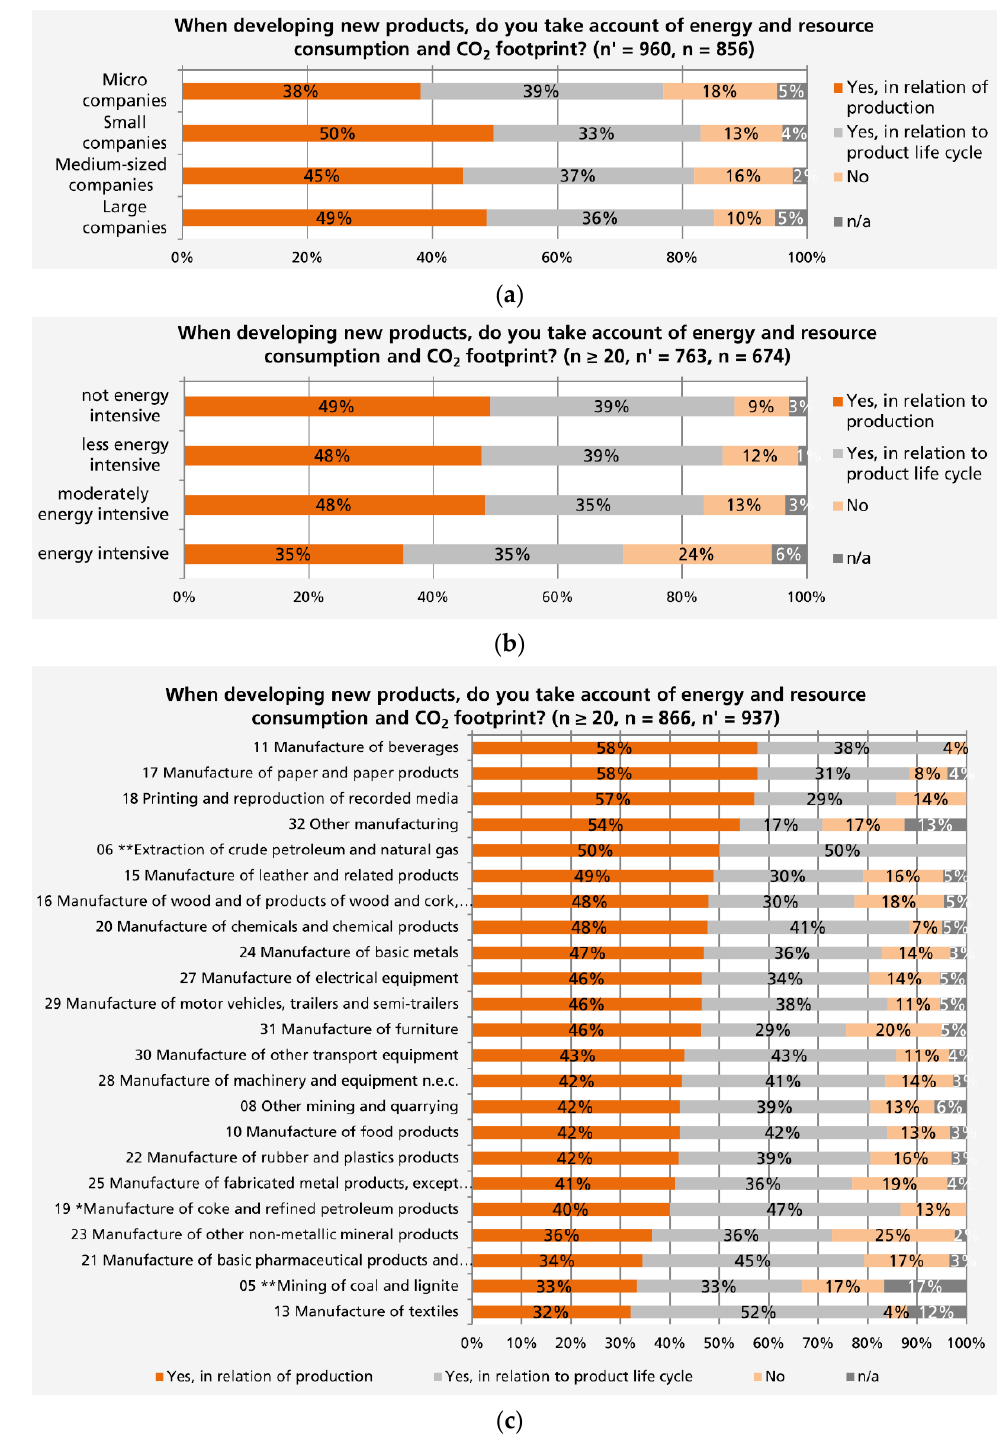
Figure 2. ( a ) Consideration of energy/resource consumption and footprint in product development, by company size; ( b ) consideration of energy/resource consumption and footprint in product devel- opment, by energy intensity; and ( c ) consideration of energy/resource consumption and footprint in product development, by sector.